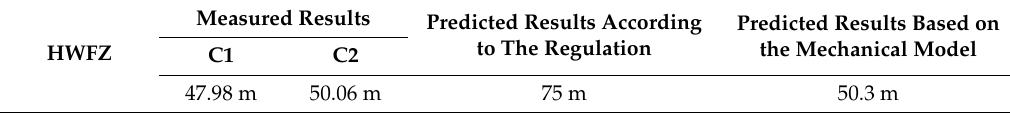
Table 2. Comparison between the measured and predicted results of